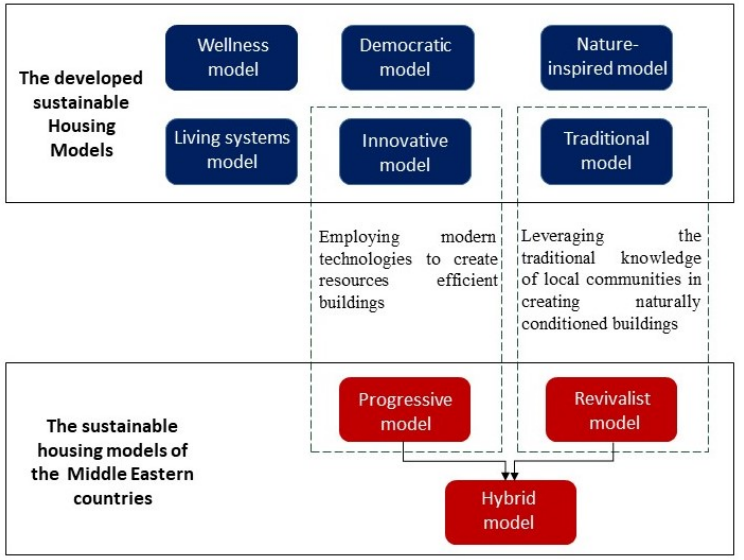
Figure 8. Linking the sustainable housing trends in Arab countries with the developed sustainable housing models (Authors).